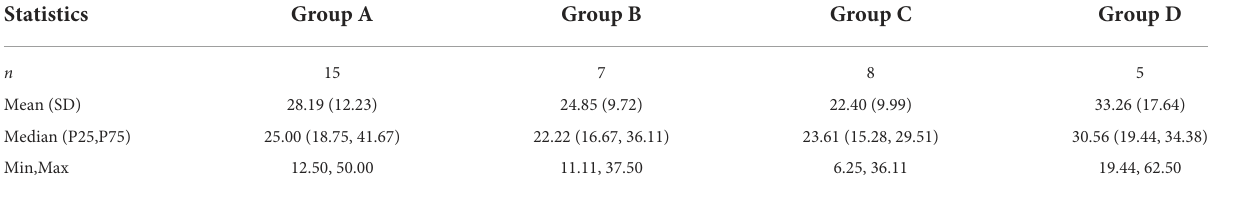
TABLE 6 Comparison of NPQ scores between groups before